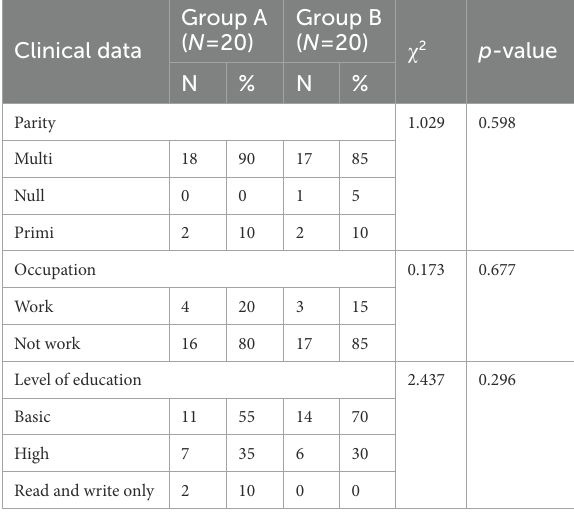
Significance is considered at p < 0.05.